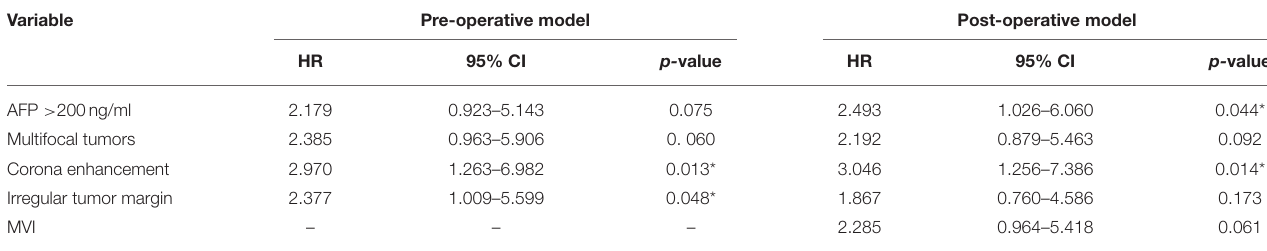
TABLE 3 | Multivariate analysis of preoperative and postoperative independent predictors for early recurrence of eHCC patients ( n = 82).